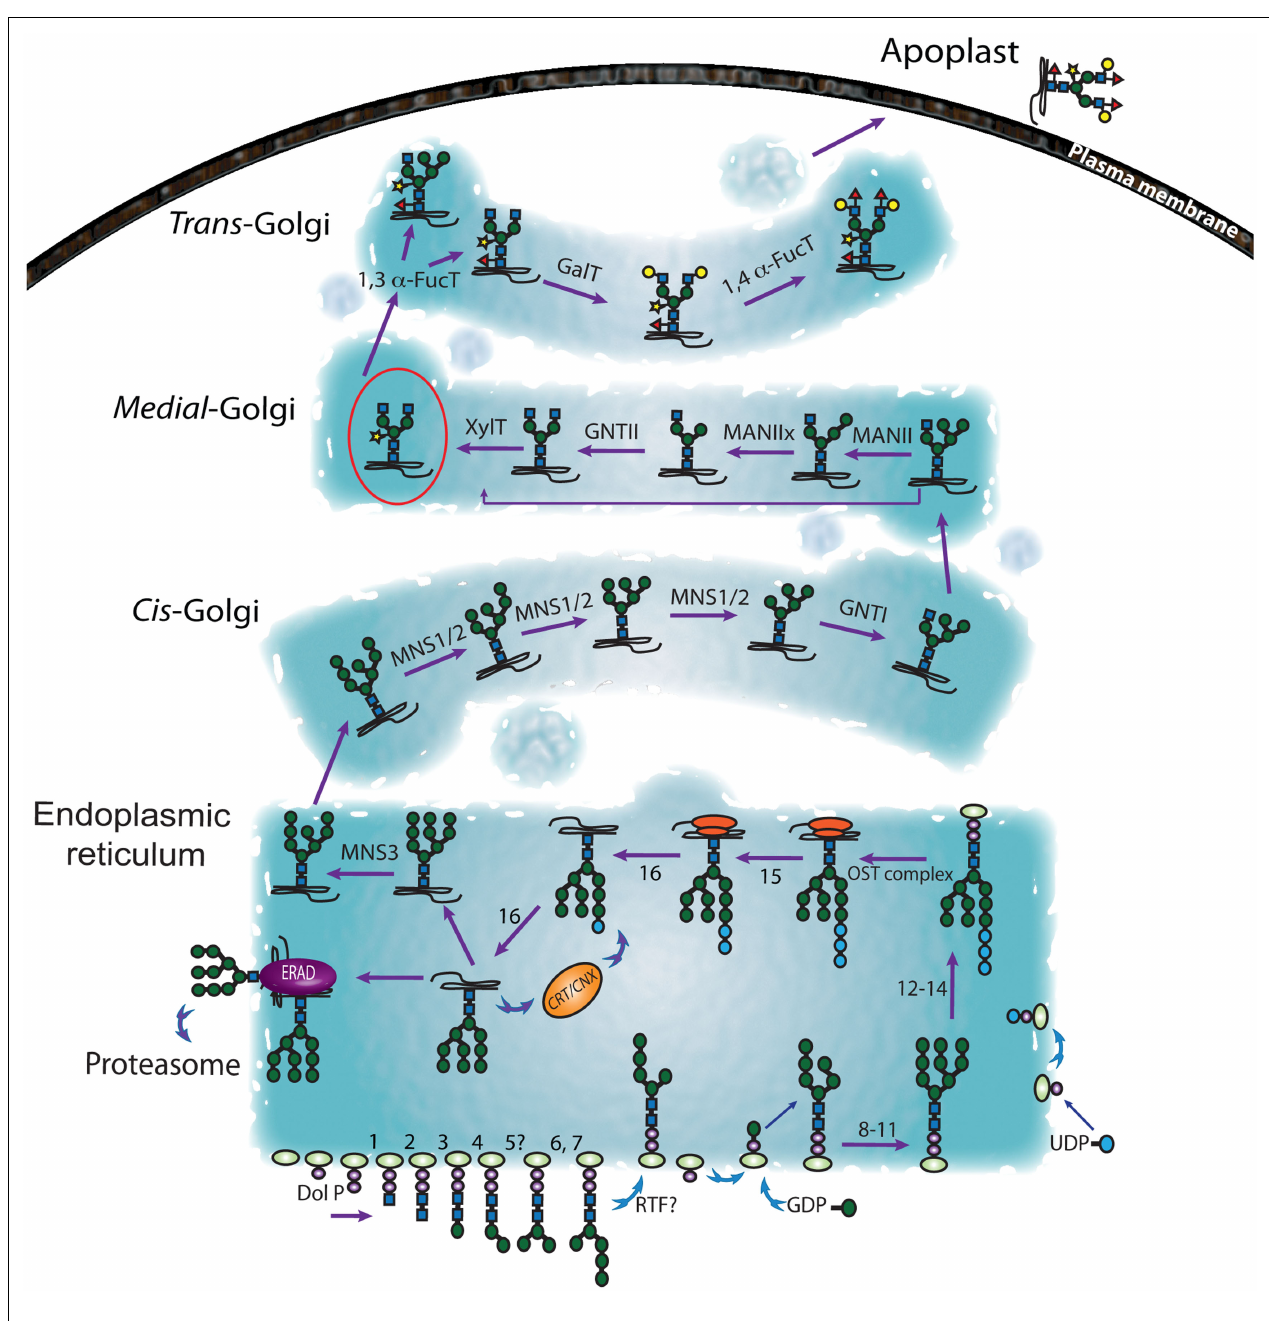
(Hebert et al., 1995; Crofts et al., 1998; Helenius and Aebi, 2004; Jin et al., 2007; Lederkremer, 2009). Glucosyl transferase and glucosidases implicated the in the sugar trimming in the ER and identified in plants so far, are enlisted in Table 1 . Subsequent modifications of the N -glycans occur in the GA and potentially in other cellular compartments, such as the chloroplast and vacuole (based on a model presented in Gomord et al. (2010).The first indirect insights into the location and orientation of plant glycosyltransferases were provided by immunolocalization of the enzyme products (Laine et al., 1991; Fitchette et al., 1994, 1999). Such studies indicated that β -1,2-xylose is added to plant N -glycans mainly in the medial Golgi while the α -1,3-fucosylation occurs predominantly in the trans-Golgi (Fitchette et al.,